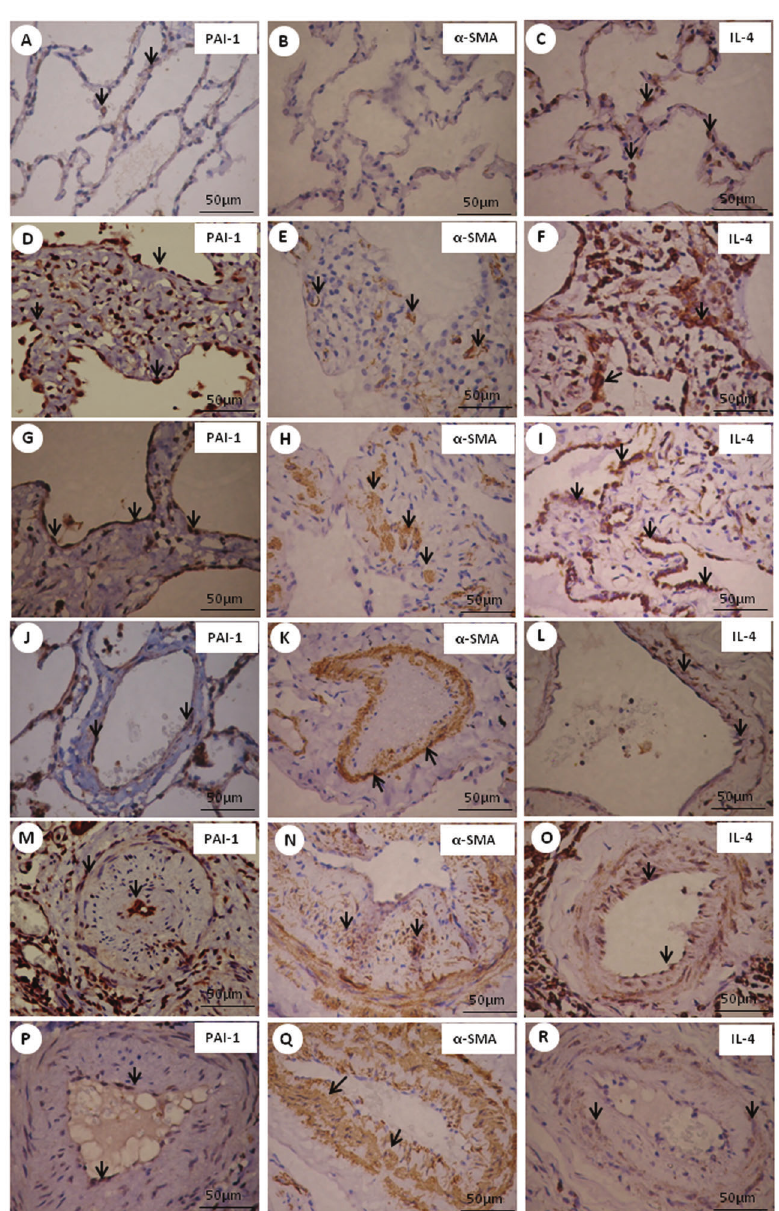
Figure 2. Immunohistochemical staining with PAI-1, a -SMA and IL-4. Cell expressions of PAI-1, a -SMA and IL-4 in septal interstitium and intrapulmonary vessels from normal and systemic sclerosis (SSc) lung tissue are shown. There is a diffuse and increased expression of PAI-1 (arrows) ( D ), a -SMA (arrows) ( E ) and IL-4 (arrows) ( F) in the septal interstitium of cellular nonspecific interstitial pneumonia (NSIP) contrasting with a minimal or without expression of PAI-1 (arrows) ( A ), a -SMA ( B ) and IL-4 (arrows) ( C ) of the control group. Comparing the expression of PAI-1, a -SMA, and IL-4 between the cellular ( D , E , F ) and fibrotic ( G , H , I ) NSIP pattern, a higher expression of a -SMA in fibrotic than in cellular NSIP was observed. Increased expression of PAI-1, a -SMA and IL-4 is observed in cellular (arrows) ( M , N , O ) and fibrotic (arrows) ( P , Q , R ) NSIP groups when compared with the control (arrows) ( J , K , L )